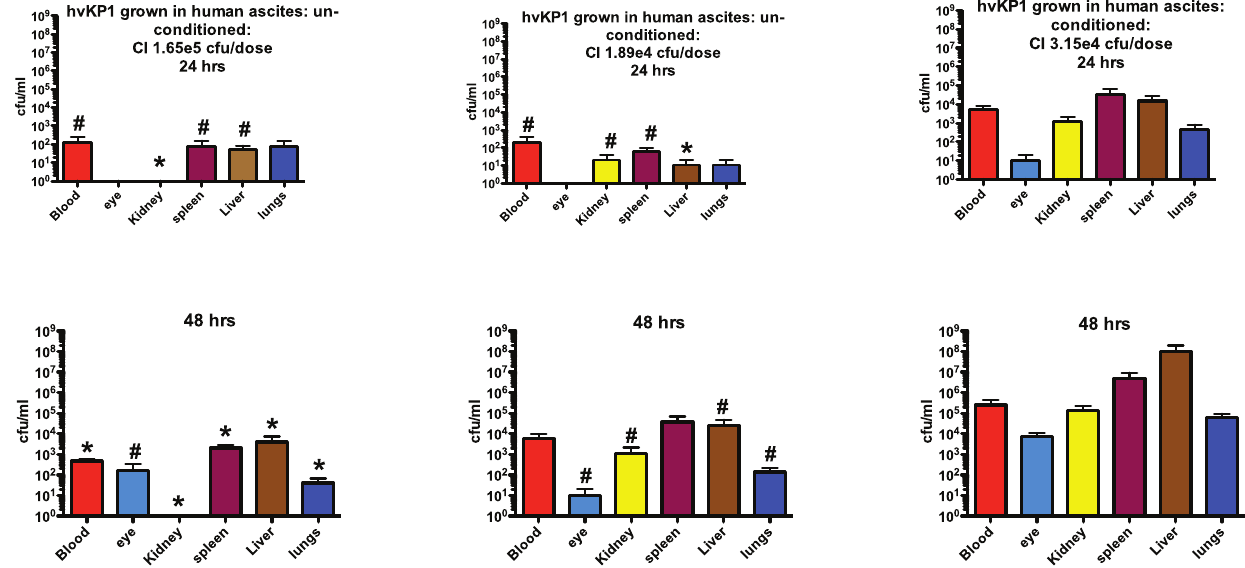
Figure 5. hvKP1 grown in conditioned ascites, compared to unconditioned ascites, resulted in significantly greater growth and/or survival and dissemination after SQ challenge of CD1 mice. Animals were challenged subcutaneously with 3.15 6 10 4 cfu of hvKP1 grown in conditioned ascites (batch 2) and 1.89 6 10 4 cfu or 1.65 6 10 5 cfu of hvKP1 grown in unconditioned ascites (batch 2)(n=6 for each condition and challenge inocula). Bacterial titers were enumerated in blood and various organs at 24 and 48 hours after challenge. After blood was obtained for culture, the vasculture was ‘‘flushed’’ with 1xPBS and organs were subsequently harvested. Comparisons were between hvKP1 grown in conditioned ascites and hvKP1 grown in unconditioned ascites. * P , 0.05/2; # P . 0.05/2 but , 0.1. Data are Mean 6 S.E.M. for n= 3.